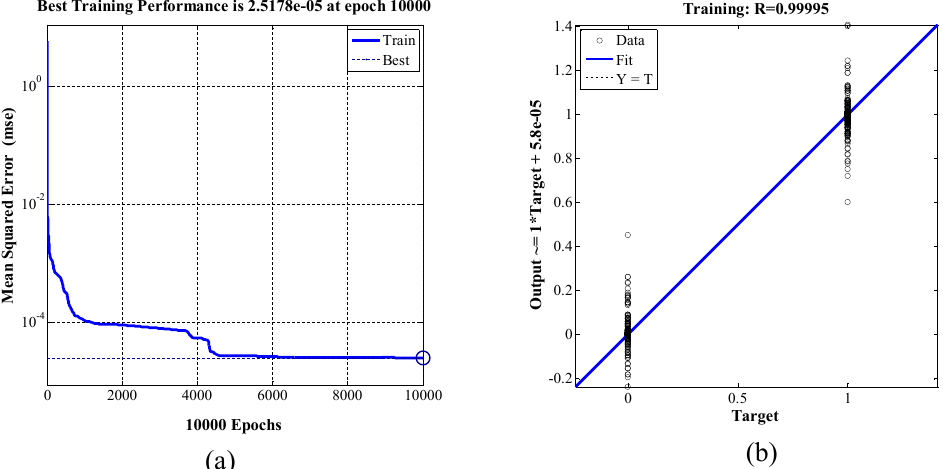
Figure 14. ( a ) Performance and ( b ) regression of ANN training after applying optimal parameters of ANN-ABC.